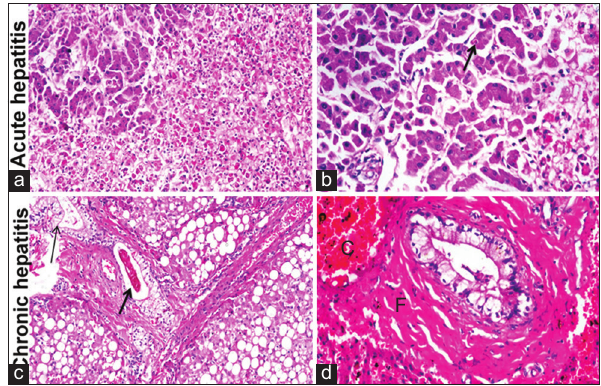
Figure-5: Histopathology findings in canine acute and chronic hepatitis groups: (a) Liver showing diffuse hepatocellular disarrangement, massive hepatocellular necrosis with inflammatory cells infiltration (200×). (b) Liver showing apoptosis of individual hepatocytes (arrow) (400×). (c) Liver showing portal fibrosis with extension of fibrous tissue into hepatic lobules associated with cholestasis (thick arrow), bile duct hyperplasia (thin arrow), and diffuse macrovesicular steatosis of hepatocytes (200×). (d) Liver showing periductular fibrosis (F), portal congestion (C), note the vacuolization of biliary epithelium